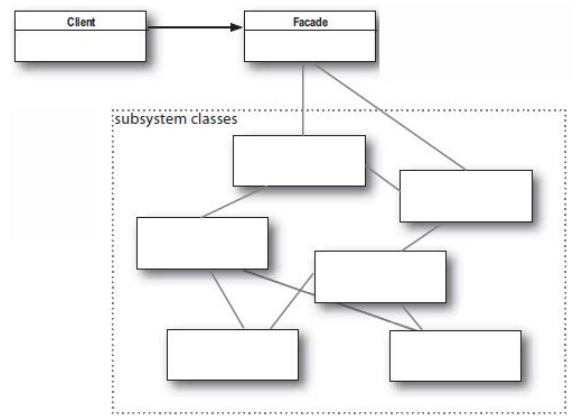
Fig. 1. Facade pattern UML diagram [4].